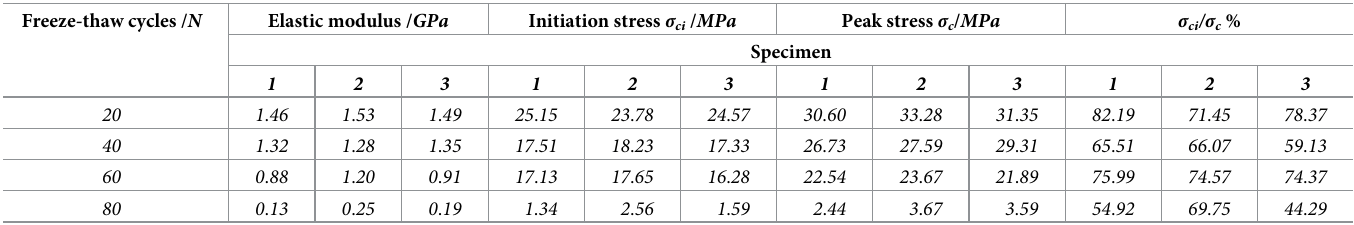
Table 1. Physical and mechanical parameters of sandstone with different freeze-thaw